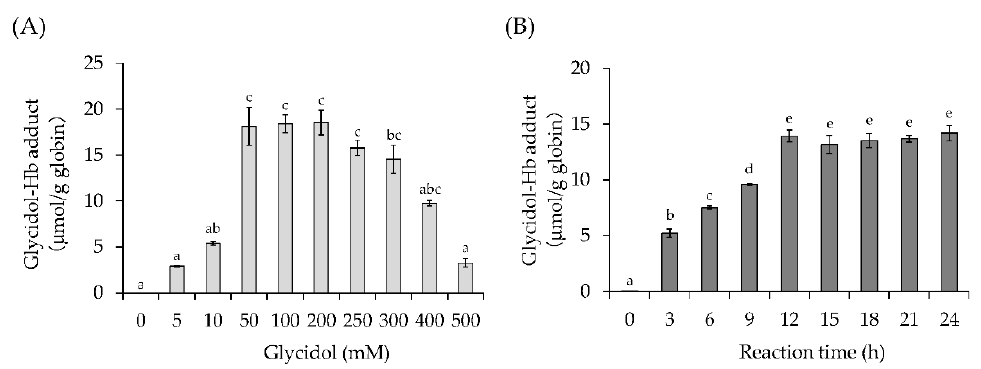
Figure 2. Effect of glycidol concentration and reaction time on glycidol – hemoglobin (Hb) adduct formation (in vitro). ( A ) Effect of glycidol concentration on glycidol – Hb adduct formation. Human Hb (final concentration 15 mg/mL) and different concentrations of glycidol were dissolved in 0.1-M phosphate buffer (pH 7.4). The solution was reacted at 37 °C for 18 h. ( B ) Effect of reaction time on glycidol – Hb adduct formation. Human Hb (final concentration 15 mg/mL) and glycidol (final concentration 200 mM) were dissolved in 0.1-M phosphate buffer (pH 7.4). The reaction solution was reacted at 37 °C for various times. Different letters indicate significant differences (Tukey – Kramer test, p < 0.05). The values represent the mean standard deviation (SD) of three independent experiments.